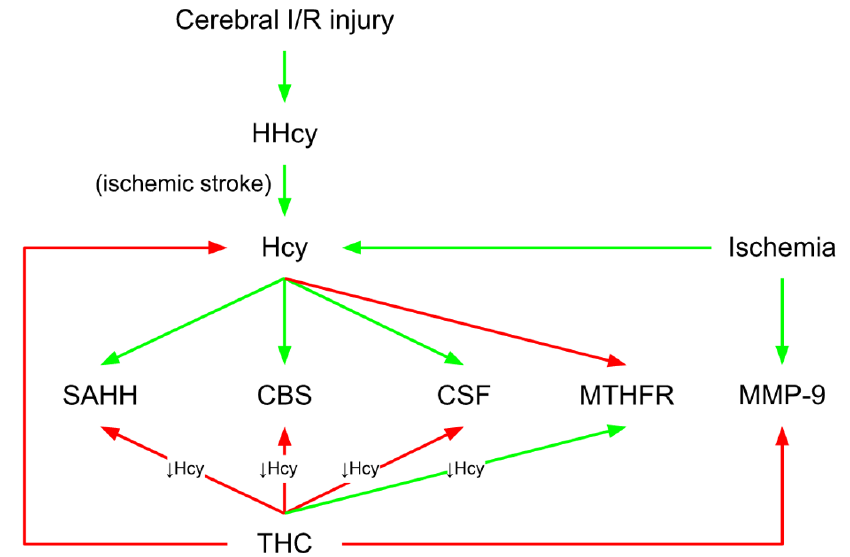
Figure 4. THC-mediated mitochondrial impact in brain vasculature. THC treatment reduced Hcy levels in the ischemic brain. Ischemic stroke altered the expression of enzymes involved in Hcy metabolisms, such as CBS, CSE, MTHFR, and SAHH. THC, tetrahydrocurcumin; Hcy, homocysteine; CBS, cystathionine- β -synthase; CSE, cystathionine gamma lyase; MTHFR, methylenetetrahydrofolate reductase; SAHH, S-adenosyl-L-homocysteine hydrolase; red arrow, inhibitory effect; green arrow, stimulatory effect.